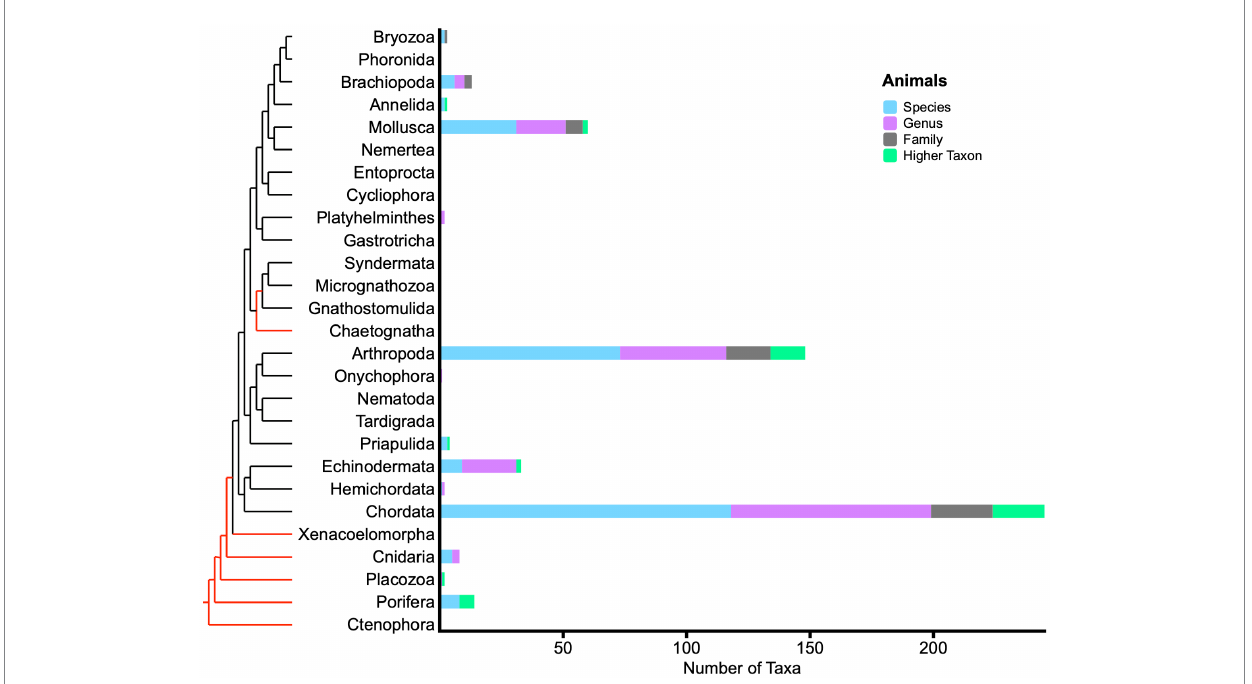
FIGURE 4 Phylogram with bar graph showing the distribution of living fossil taxa across animals. Bar colors indicate taxonomic ranks of 538 unique taxon names. Red sections of phylogram indicate significant uncertainty of relationship. Several “rogue” phyla that showed instability in a key phylogenomic analysis are not shown (Laumer et al., 2019). In our compilation, none of these latter phyla contain designated living fossils.